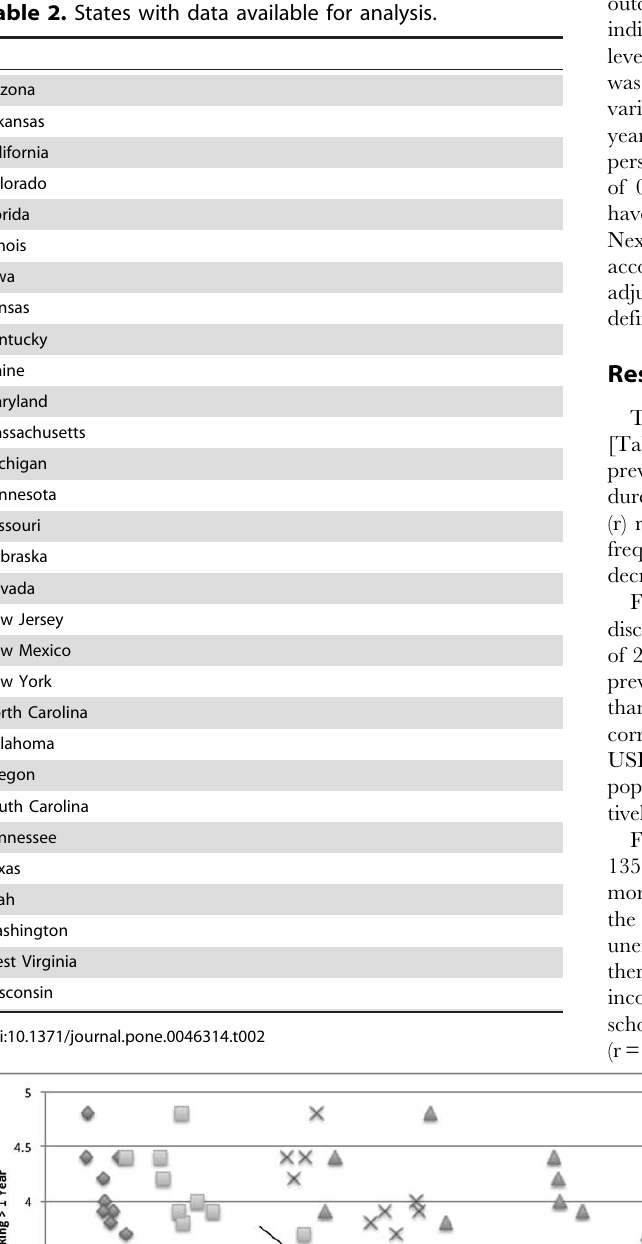
Table 2. States with data available for analysis.